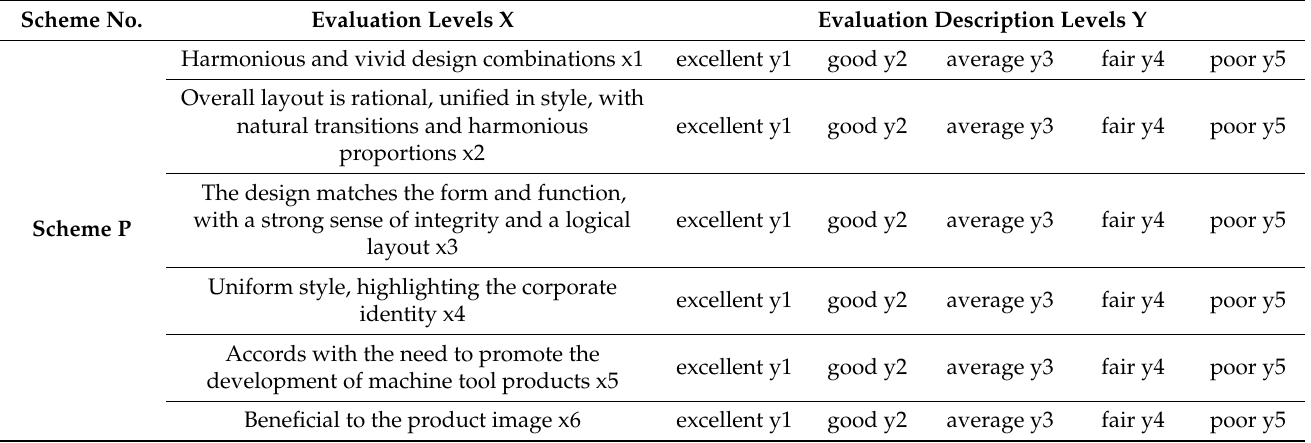
Table 5. Evaluation indicators and scoring table for the coating design